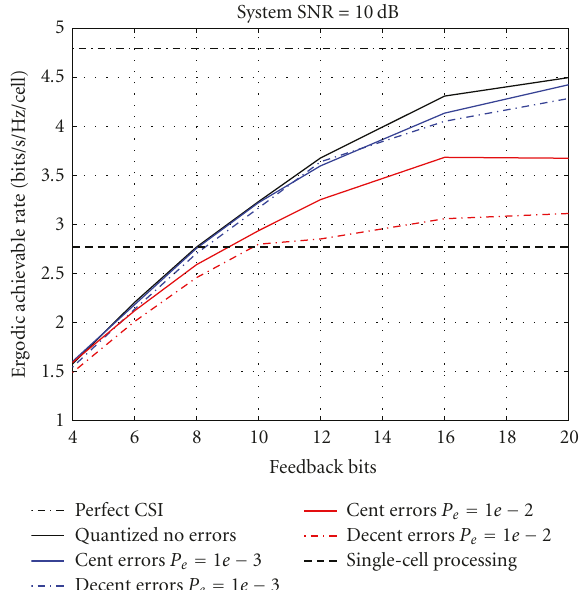
Figure 5: A plot of the ergodic achievable rate as a function of the number of feedback bits for a random codebook when System SNR is 10dB and round-robin scheduling is employed. The blue curves correspond to the case where the bit error probability is P e = 10 − 3 , whereas for the red curves P e = 10 − 2 . “Cent” denotes the centralised framework and “Decent” the decentralised one. It can be seen that with 16 bits we get relatively close to the performance of the perfect CSI case in the absence of feedback errors (black uppermost